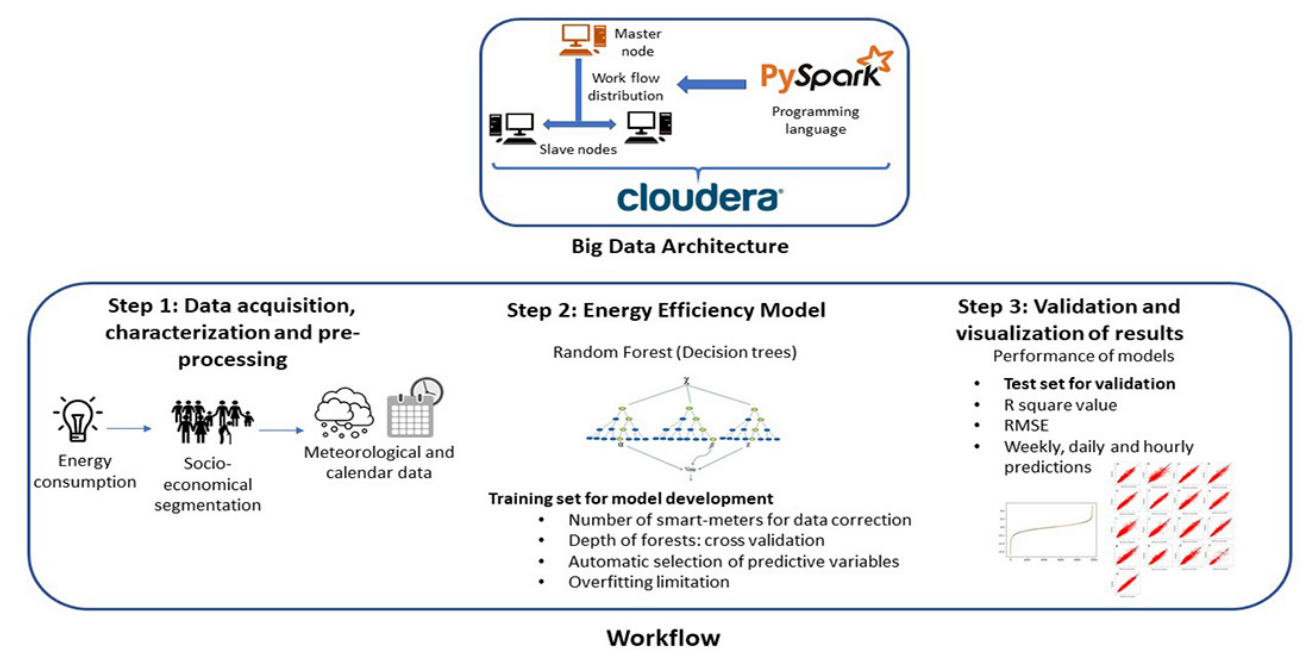
Figure 1. Main workflow proposed: Data acquisition and preprocessing, Energy eddiciency model and Validation of